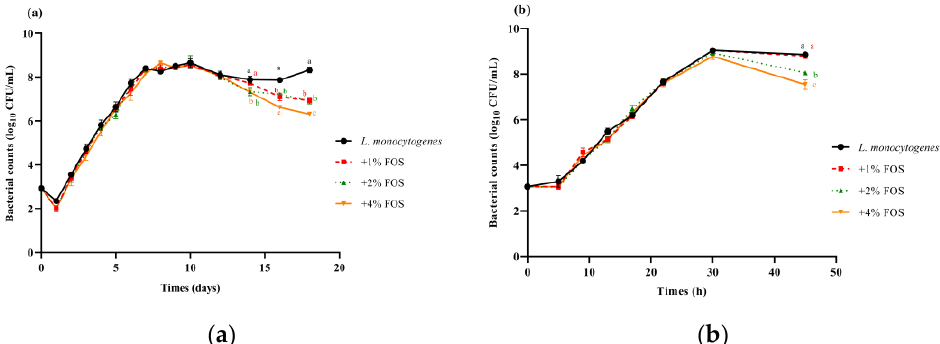
Figure 1. Growth kinetics of L. monocytogenes with the presence of 1% ( w / v ) FOS, 2% ( w / v ) FOS, or 4% ( w / v ) FOS in BHI at 10 °C for 18 days ( a ) and at 25 °C for 45 h ( b ). Data represented as log 10 (CFU/mL) are mean values ± SD with ( n = 6).